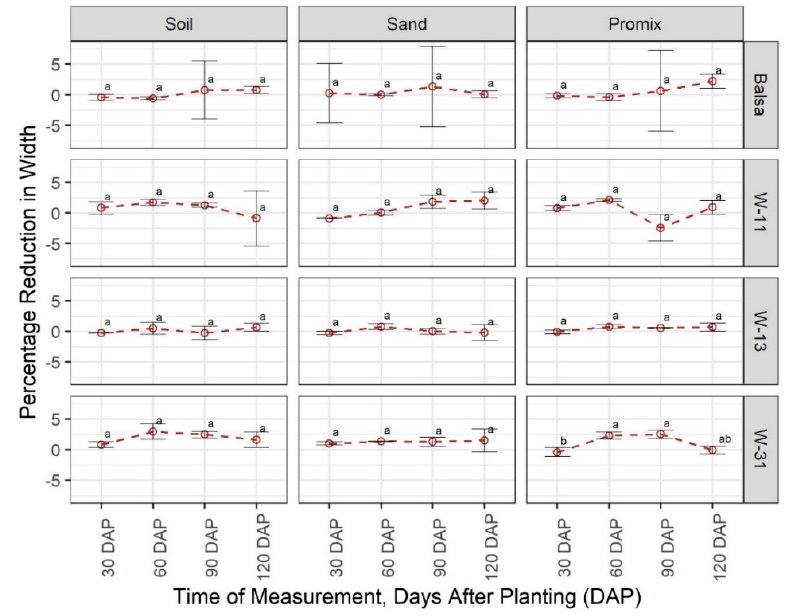
Figure 3. Comparison of percentage change in material width in three growing media (Promix, sand, and soil) at four growth stages (30, 60, 90, and 120 days after transplanting (DAP)). Different lowercase letters indicate significant differences in % width change between different growth stages, at α = 0.05, within each growing media and material, whereas same letters indicate no significant difference across compared treatments. W-11, 1:1 blend of beeswax and soy wax; W-13, 1:3 blend of beeswax and soy wax; and W-31, 3:1 blend of beeswax and soy wax.